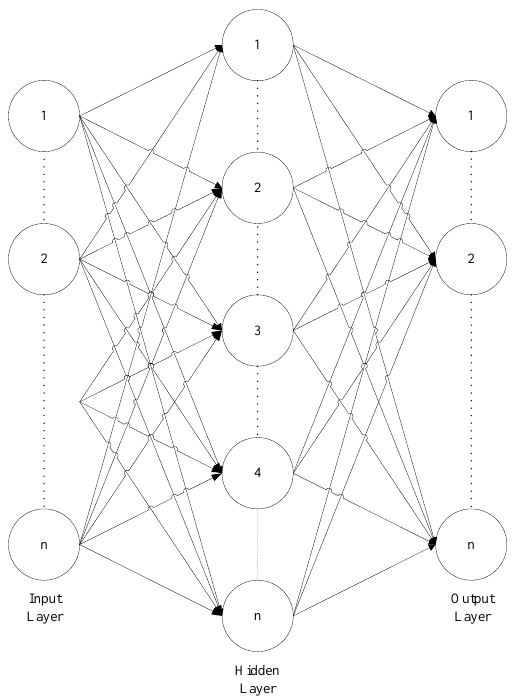
Figure 2. The structure of multilayer perceptron having a single hidden layer.